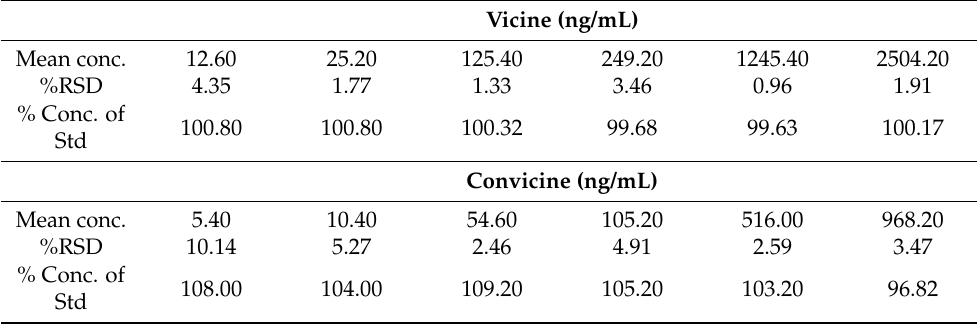
Table 3. Accuracy and precision of the method comparing the mean concentration of the replicate injections ( n = 5), the variation between injections (%RSD) and the difference between the calculated concentration of the standard and the expected concentration of the standard (% Conc. of Std) for vicine and convicine.